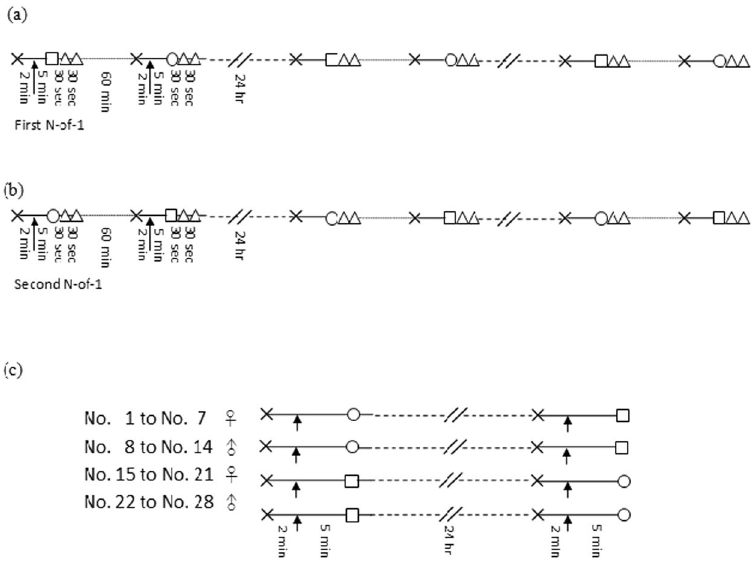
Figure 3. Flowchart of the different study designs. ( a ) First experimental episode of the N-of-1 on one female subject; ( b ) Second experimental episode of the N-of-1 on one female subject ( c ) Crossover study on 28 subjects. The interventional studies included prewash with water rinsing (cross), then direct dispersing of 0.5 mL of 1000 μ g/mL standard DEHP solution evenly over both hands (arrow), handwashing with soap and water (circle) or water only (square), and additional water rinsing (triangle). A washout period of 60 min was implemented between each handwashing intervention, and repeats of the intervention pairs were separated by 24